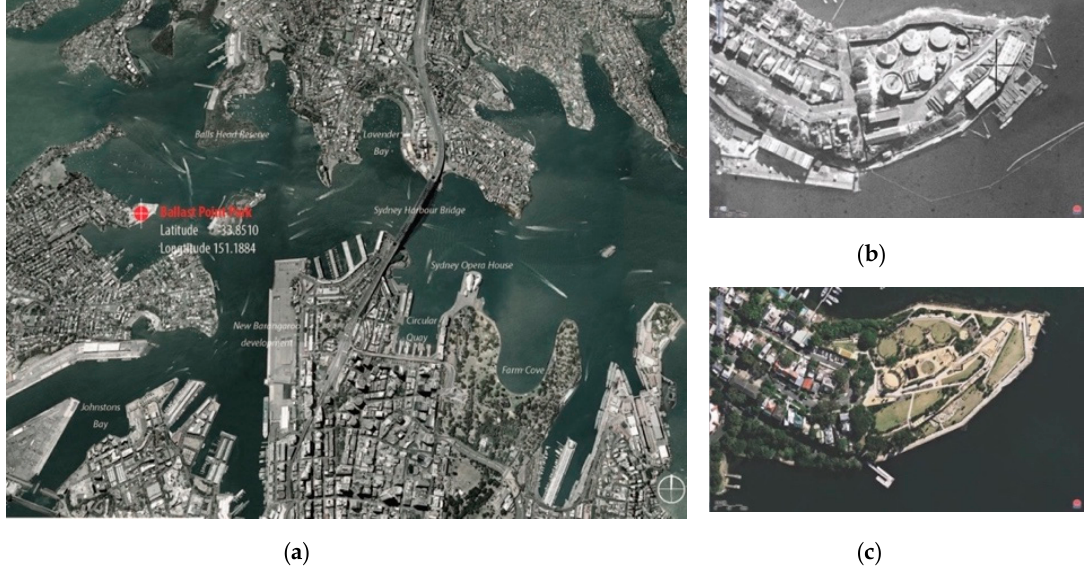
Figure 1. ( a ) Ballast Point Park (BPP) location map illustrates the Sydney Harbor context, map extracted from Google Earth; ( b ) 1943 BPP site; ( c ) 2010 BPP site, maps extracted from maps.six.ns.gov.au.